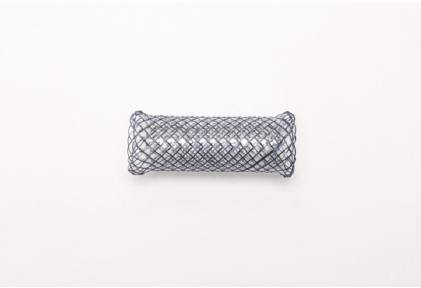
Figure 1: Micro-Tech straight fully covered self-expandable metallic stent